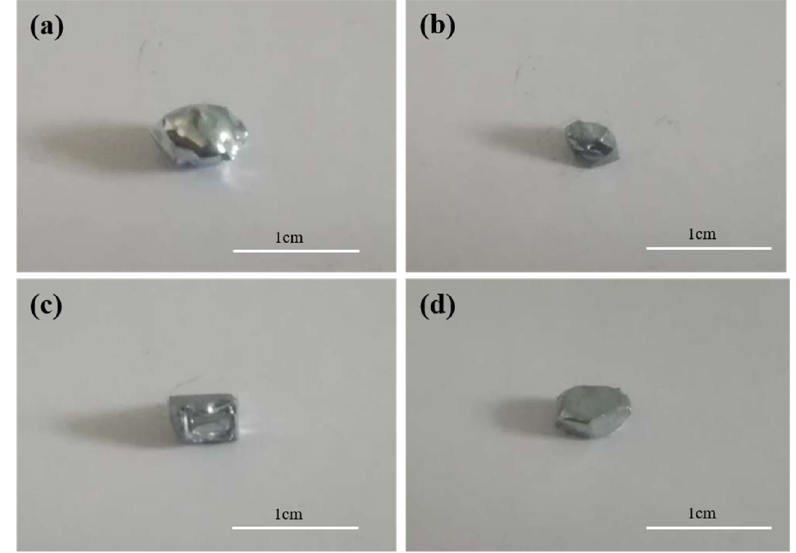
Figure 2. Morphology of the seed crystals prepared at different cooling temperatures (( a ) 265 K, ( b ) 273 K, ( c ) 278 K, and ( d ) 295 K).